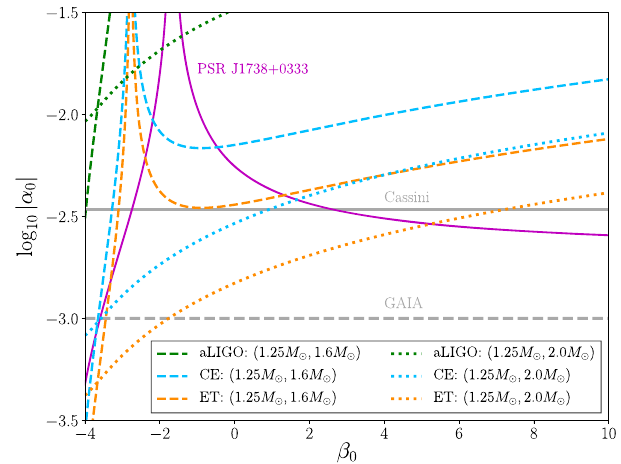
FIG. 9. Upper limits on j α 0 j as a function of β 0 for aLIGO (green line), CE (blue line), and ET (orange line) [16]. The dashed lines correspond to a 1 . 25 M ⊙ = 1 . 6 M ⊙ BNS merger, and the dotted lines correspond to a 1 . 25 M ⊙ = 2 . 0 M ⊙ BNS merger. The chosen EOS is AP4 . For comparison, we have plotted Solar System limits (grey line) and the limits from PSR J 1738 þ 0333 (magenta line), which currently give the best limit for β 0 ≳ 3 . The limit from Cassini [62] and the limit expected from GAIA [91] are also